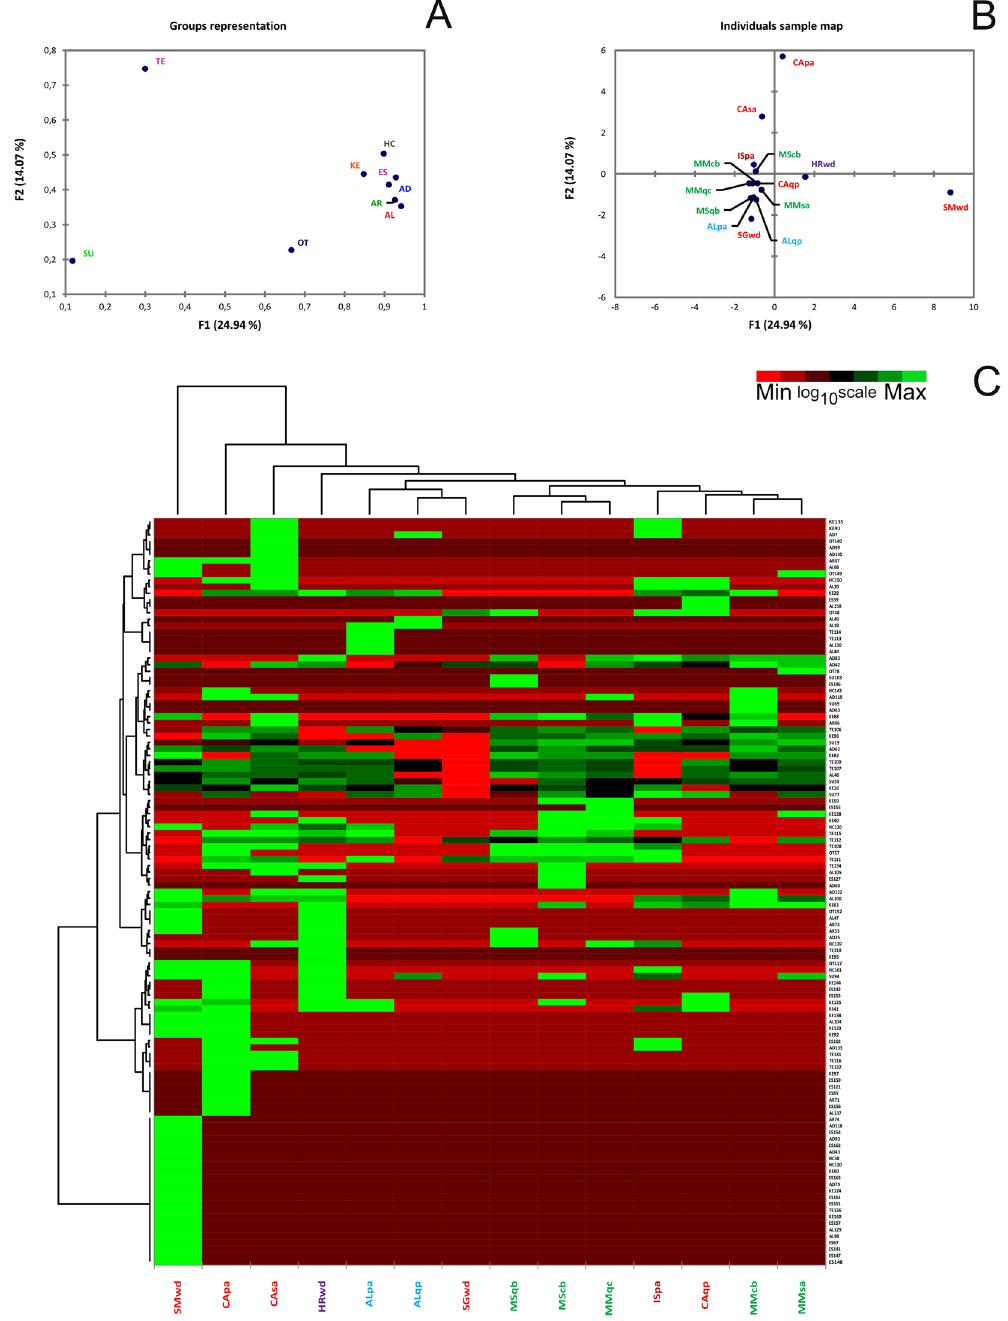
Figure 2. Multi factor analysis (MFA) of VOCs analysed by GC-MS. F1 = first dimension, F2 = second dimension. Data were log 10 + 1 transformed. ( A ) Representation of groups of variables. Key codes: AL = Alcohols; AD = Aldehydes; AR = Aromatic compounds; ES = Esters; HC = Hydrocarbons; KE = Ketones; OT = Others; SU = Sulfur containing compounds; TE = Terpenes. ( B ) Representation of the selected samples in the multidimensional space of the MFA (F1, F2). The total inertia ( i.e ., total variance) included in the first two dimensions of the MFA was 39.01%. ( C ) Heat map based on the quantitative data obtained from GC-MS and GC-FID analysis. Samples are listed in Table 1, while compounds identified through GC-MS and GC-FID analysis are reported as Supplementary Information (Table S3). Data were log 10 + 1